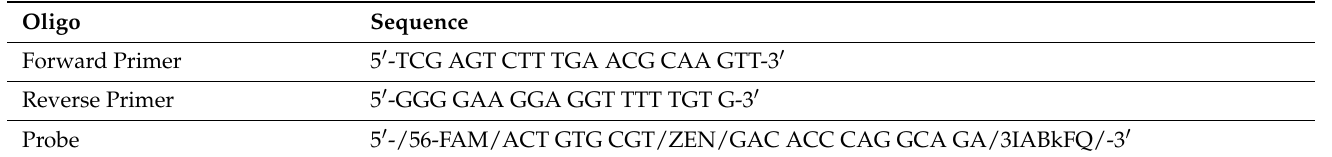
Table 2. Primer and probe sequences used in Carica papaya